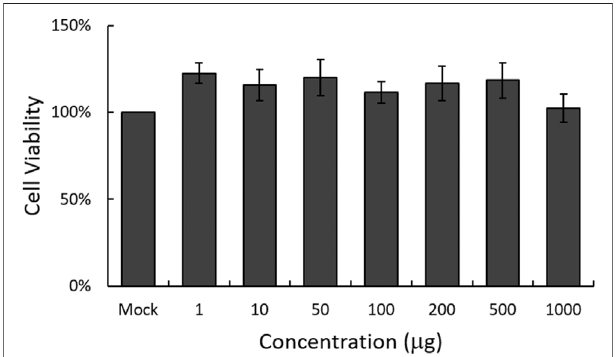
FIGURE 1 | Determination of the cytotoxicity of EBL in RAW 264.7 cells. EBLwasaddedtothecellswithindicatedconcentrationsfor24 hat37 ° C.Cell viability was assessed by CCK-8 assay. The data represent the mean ± SD based on three replicates in three different